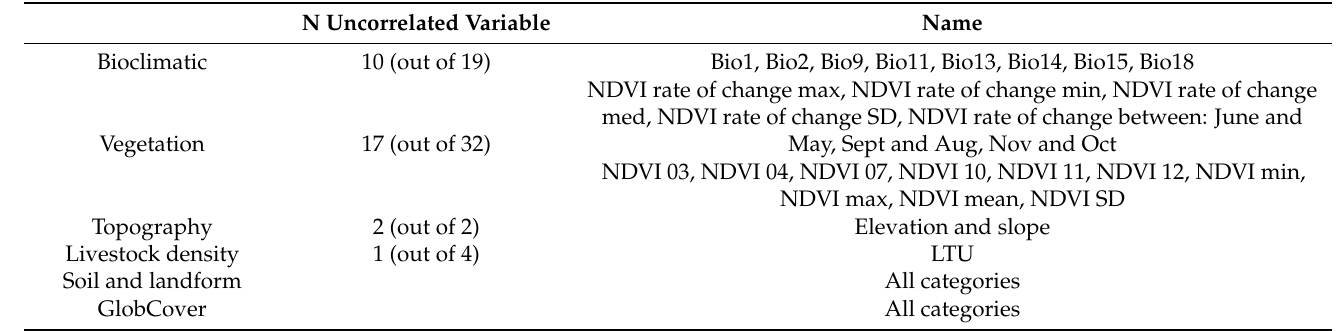
Table 2. Uncorrelated predictors based on the results of the correlation matrix. Total number of analyzed predictors in brackets. Legend and acronyms as of Table